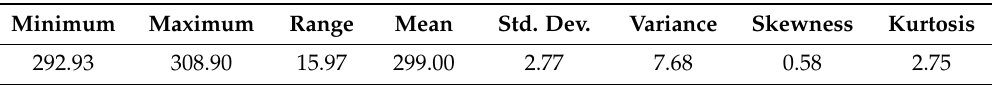
Table A3. Air outlet temperature distribution statistics [K], measured using “Hobo” sensors. Minimum Maximum Range Mean Std. Dev.